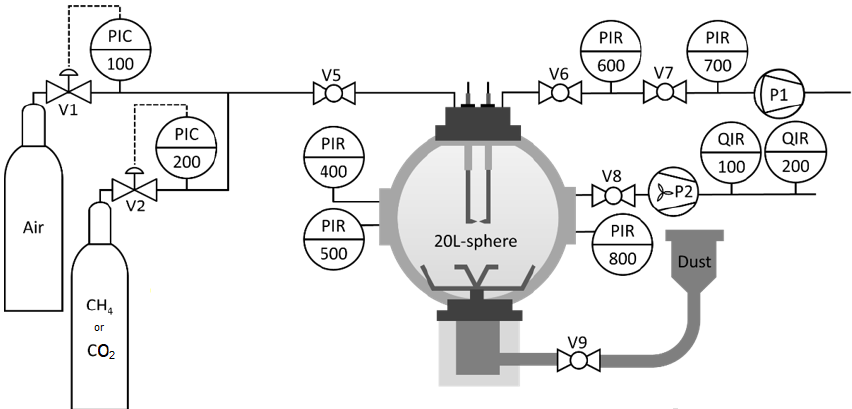
Figure 3. Schematic of the standard 20 L-sphere with adaptations for hybrid mixture testing, gas amount just inside the 20 L-sphere.